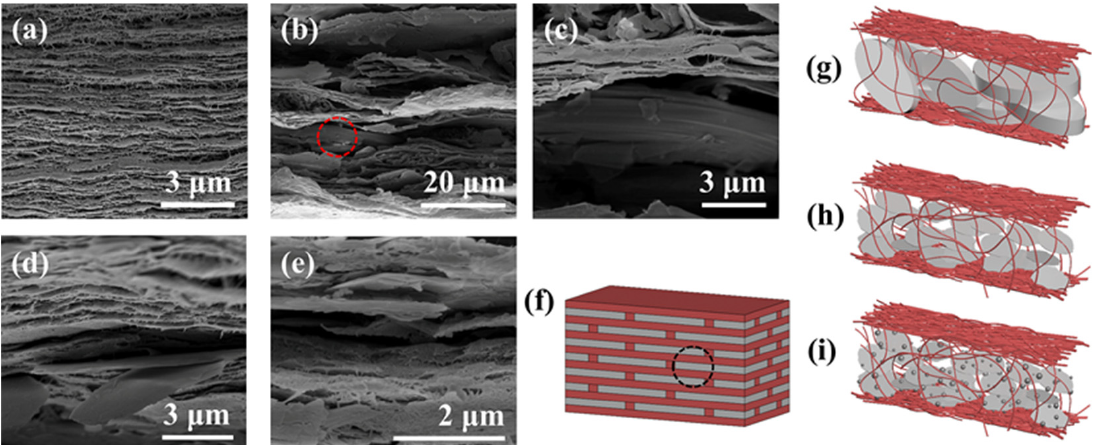
Figure 3. SEM images of the fractured surfaces of ( a ) pure ANF, ( b ) ANF/h-BN, ( c ) SEM image with higher magnification corresponding to ( b ). ( d ) ANF/BNNS, and ( e ) ANF/BNNS@Ag thermally conductive composite films. ( f ) Schematic diagrams of the structure of thermally conductive composite films. Schematic diagrams of the structure of magnification of ( g ) ANF/h-BN, ( h ) ANF/BNNS, and ( i ) ANF/BNNS@Ag conductive composite films.